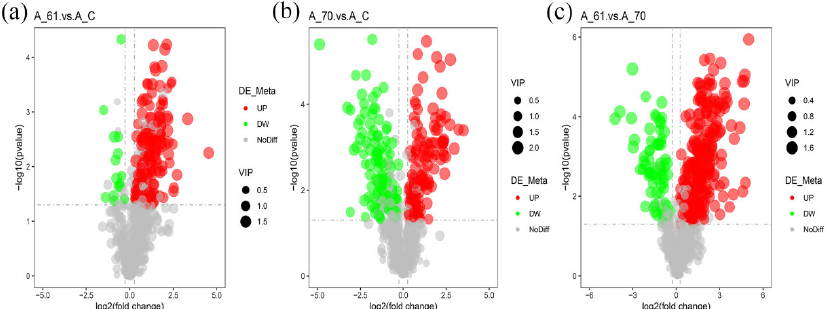
Figure 9. Venn diagram of differential metabolites.